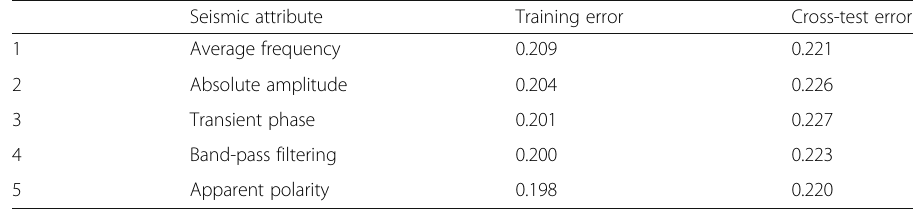
Table 1 The first five seismic attributes used for multi-attribute inversion Seismic attribute